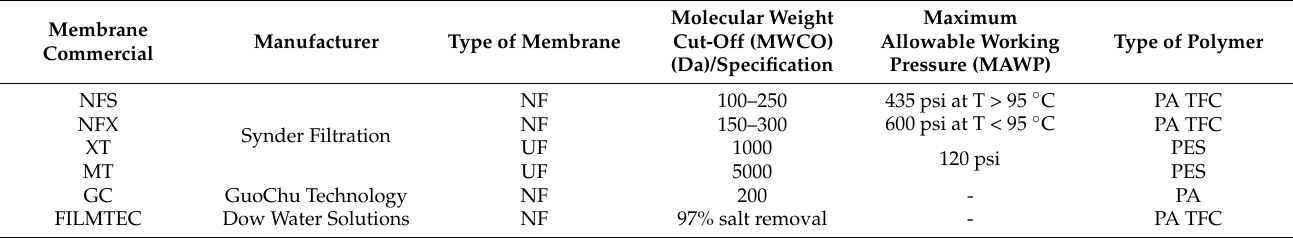
Table 1. Specification of the utilized